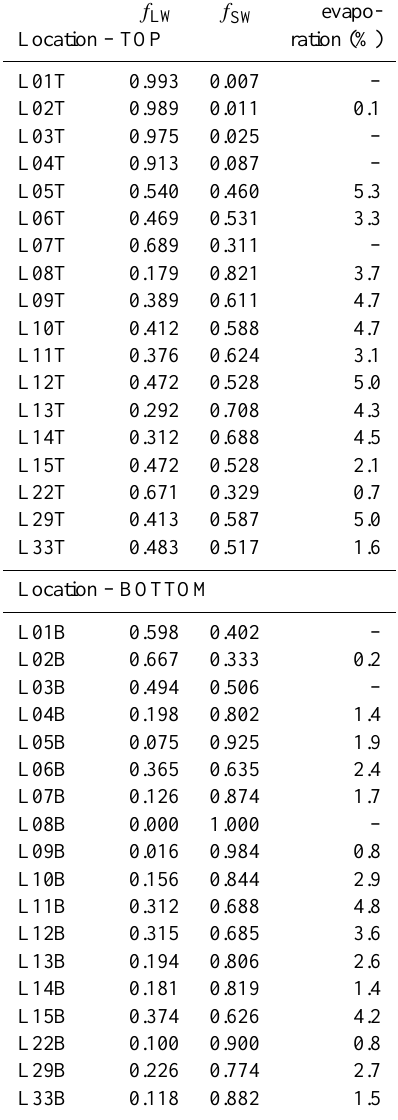
Table 3. Average results of two-component endmember mixing analysis giving the contributions of lake water ( f LW ) and seawa- ter ( f SW ) in the lagoon top and bottom for the dry season; average relative percentages of evaporation calculated for dry season based on data correction (details given in